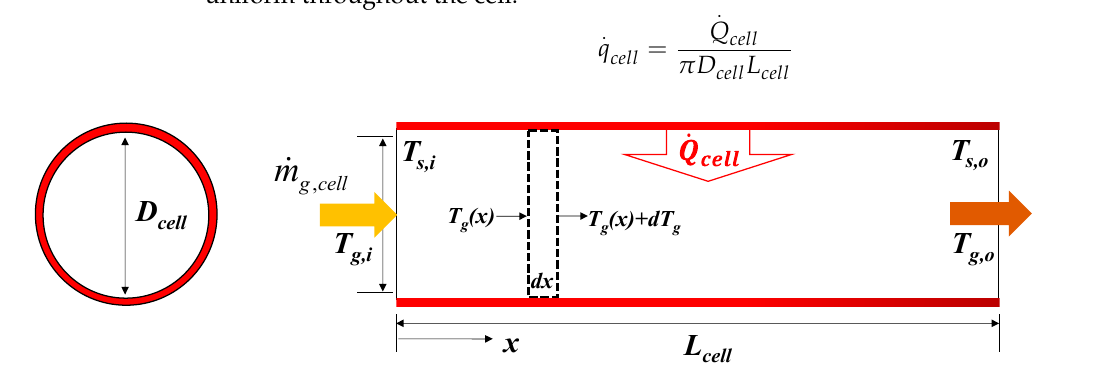
Figure 3. Conceptual illustration showing the governing parameters of flow and heat transfer in a flow cell for the 1D analysis.